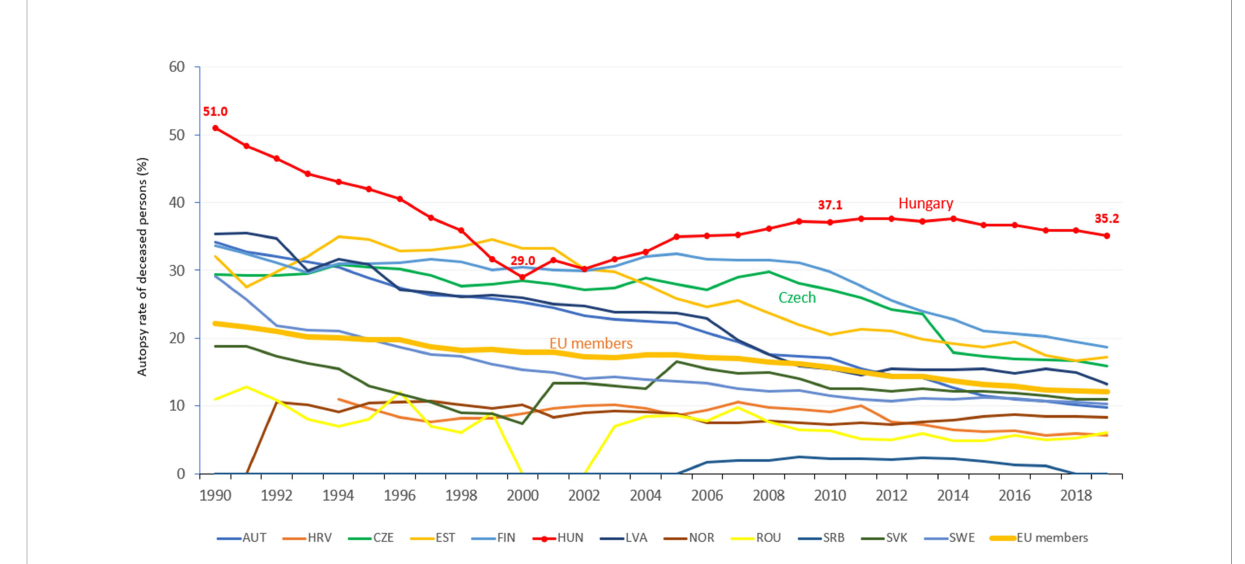
FIGURE 4 Autopsy rate (%) for all deaths in European countries (where data available). Source: WHO – European Health Information